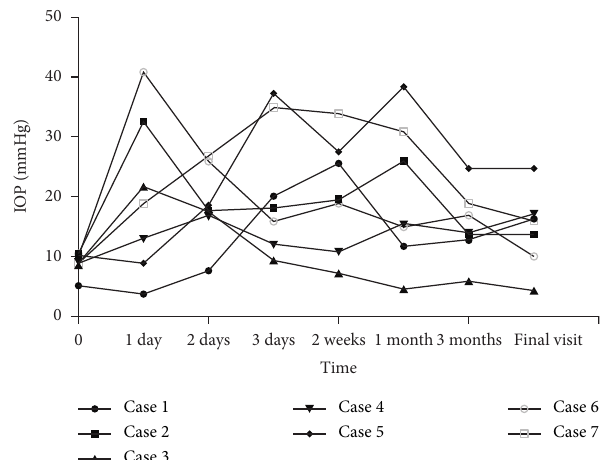
Figure 2: Postoperative intraocular pressure (IOP) profile fol- lowing vitrectomy with air endotamponade in all